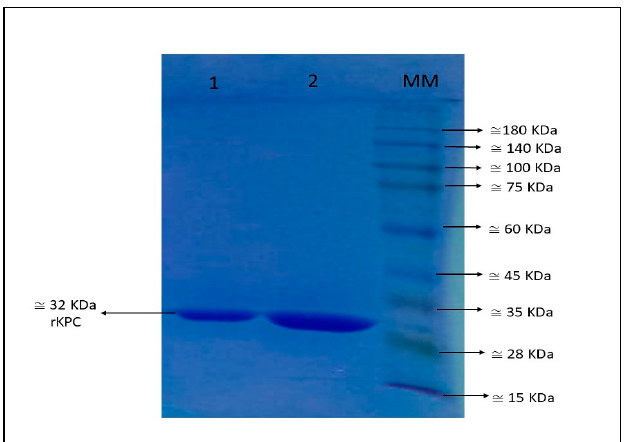
Figure 2. Presence of purified rKPC-2 on SDS–PAGE gel. The top two fractions were collected from AKTA equipment. Legend, 1: Tube 17, 2: Tube 18, MM: molecular marker.